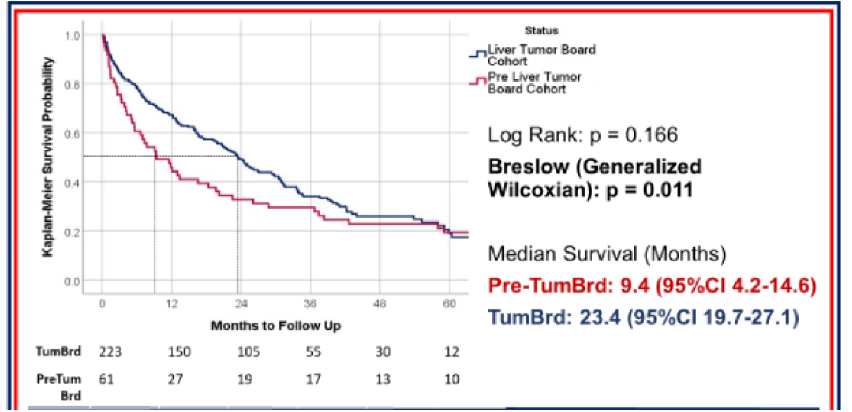
Figure 4. Median survival of patients with liver cancer in VISN 2 before and after implementation of MDTB.